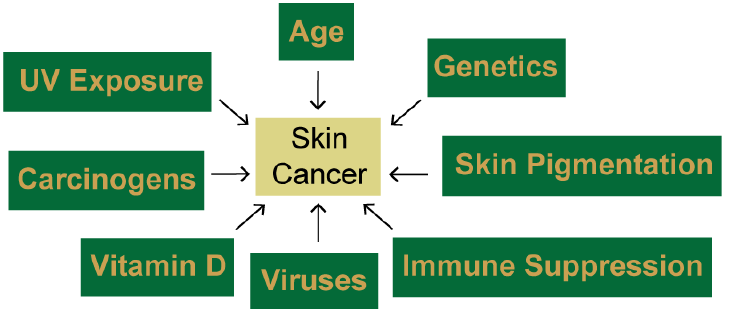
Figure 1. Multiple factors influence skin cancer development. Though exposure to UV radiation is a major contributor to skin carcinogenesis, other factors, including age, genetics, skin pigmentation, immunosuppression, viruses, and other carcinogens are also known to influence the likelihood of developing skin cancer. Though the mechanisms by which many of these risk factors contribute to mutagen- esis and carcinogenesis in the skin have been studied to a reasonable extent, a new and less explored contributor is the body’s circadian rhythm. As will be discussed in greater detail below, research over the past few years has demonstrated that each of these factors is affected in some way by either the time of day or by genetic components that make up the body’s circadian clock machinery. 2. The Circadian Clock 2.1. Central and Peripheral Clocks Though circadian (Latin for “about a day”) behaviors have been recognized and ob- served in organisms for centuries, it was not until the late 1970s that a genetic basis for circadian rhythms was found. Thus, as is true for understanding many aspects of bio- chemistry and physiology, model organisms were key to elucidating the molecular mech- anism of the circadian clock. The isolation of a Drosophlia mutant with altered circadian behavior (known as period) in the 1980s ultimately led to the cloning and characterization of both the period gene and other circadian clock components. This discovery led to Jef- frey C. Hall, Michael Rosbash, and Michael W. Young being awarded the 2017 Nobel Prize in Physiology or Medicine [33]. In the 1990s, the development of the first knockout mice lacking evolutionarily conserved clock genes [34] initiated a field of research that contin- ues today, revealing a seemingly unending number of systems and pathways that are controlled in part by the body’s circadian clock. Moreover, as will be described in greater detail below, this regulation also extends to the skin. A simplified model of how the body’s circadian clock is set and synchronized is pro- vided in Figure 2. The “master clock” is found in the suprachiasmatic nucleus (SCN) in the anterior part of the hypothalamus of the brain [35]. Specialized photosensitive retinal ganglion cells in the eye sense light via the photopigment melanopsin and then this infor- mation to the SCN through the retinohypothalamic tract. The light that is sensed by the retina, therefore, allows for entrainment, or synchronization, of daily rhythms to the 24 h light-dark cycle which occurs because of the earth’s rotation. Then, via neuronal and hor- monal signaling, the SCN sends signals to other peripheral organs to keep tissues syn- chronized to the master clock in the brain. Ultimately, these processes affect aspects of physiology that display circadian rhythmicity in humans, including blood pressure, body temperature, and the release of the hormones cortisol and melatonin.